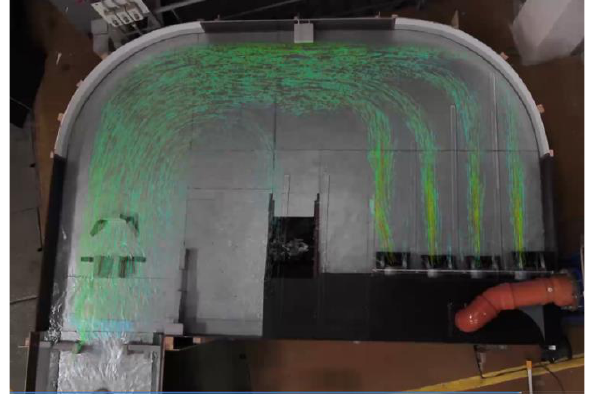
Figure 5. Final model confirmation.